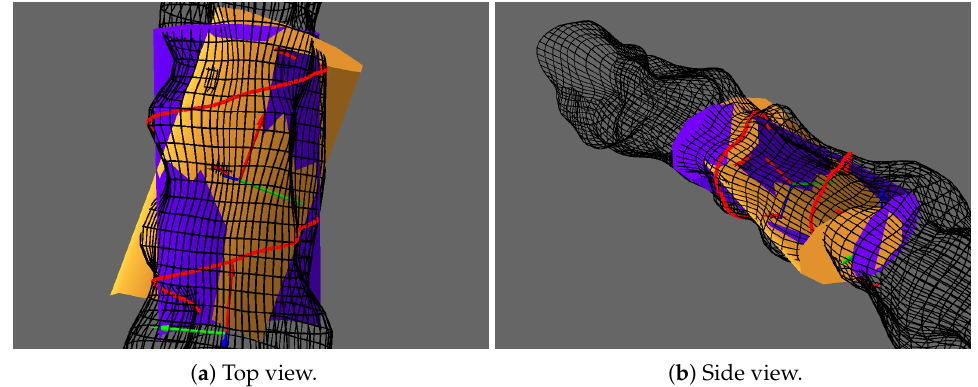
Figure 5. Elliptic cylinder fitting of vertical sonar points for the prior shape illustrated from Top ( a ) and Side ( b ) views. The RPCA results are represented in orange and the final results after Levendberg–Marquardt optimization in purple. The RPCA base is represented by a frame in the center of the